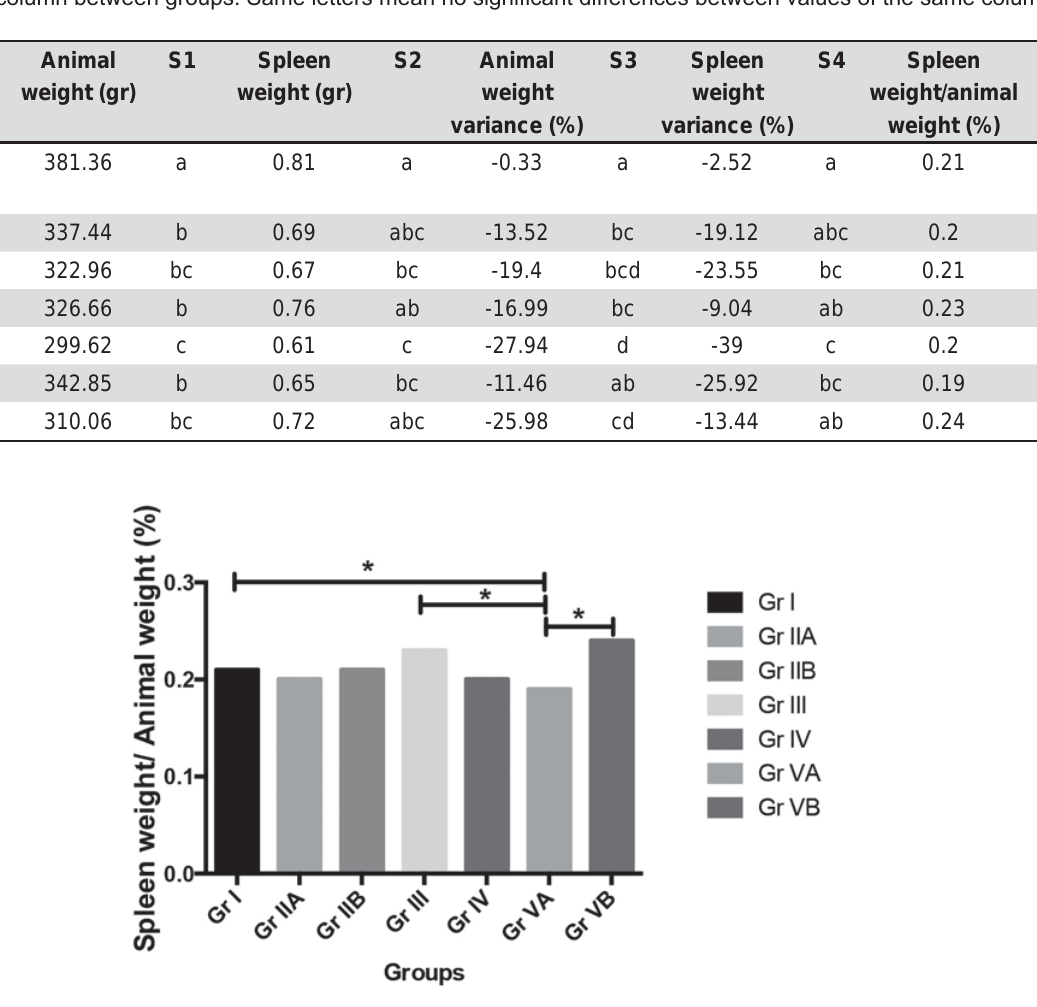
Table 2- Results of statistical analysis for comparison of animal and spleen weights. The “S1-S5” represents the various